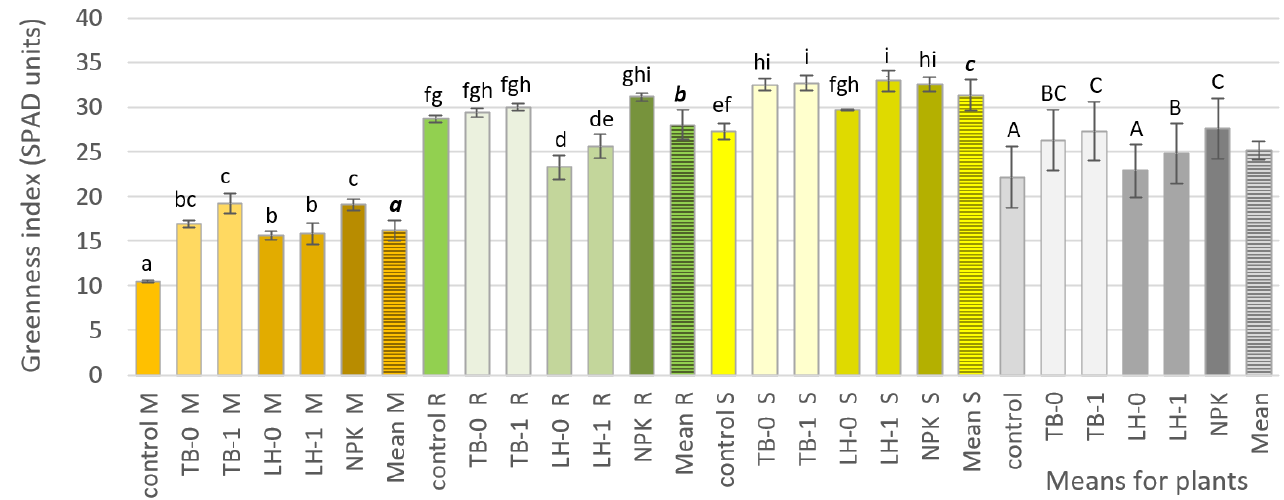
Figure 1. Leaf greenness index (SPAD) of maize, rapeseed forage, and sunflower under different PM treatments. Values are means, error bars indicate the standard error (SE) of the means; means followed by different letters are significantly different by the LSD p ≤ 0.05 test (uppercase—the differences between fertilizers used, lowercase italic—the differences between plant reactions, lowercase regular—interaction of fertilization vs. plant − soil reactions); M—Maize, R—Rapeseed forage S—Sunflower; n = 3.